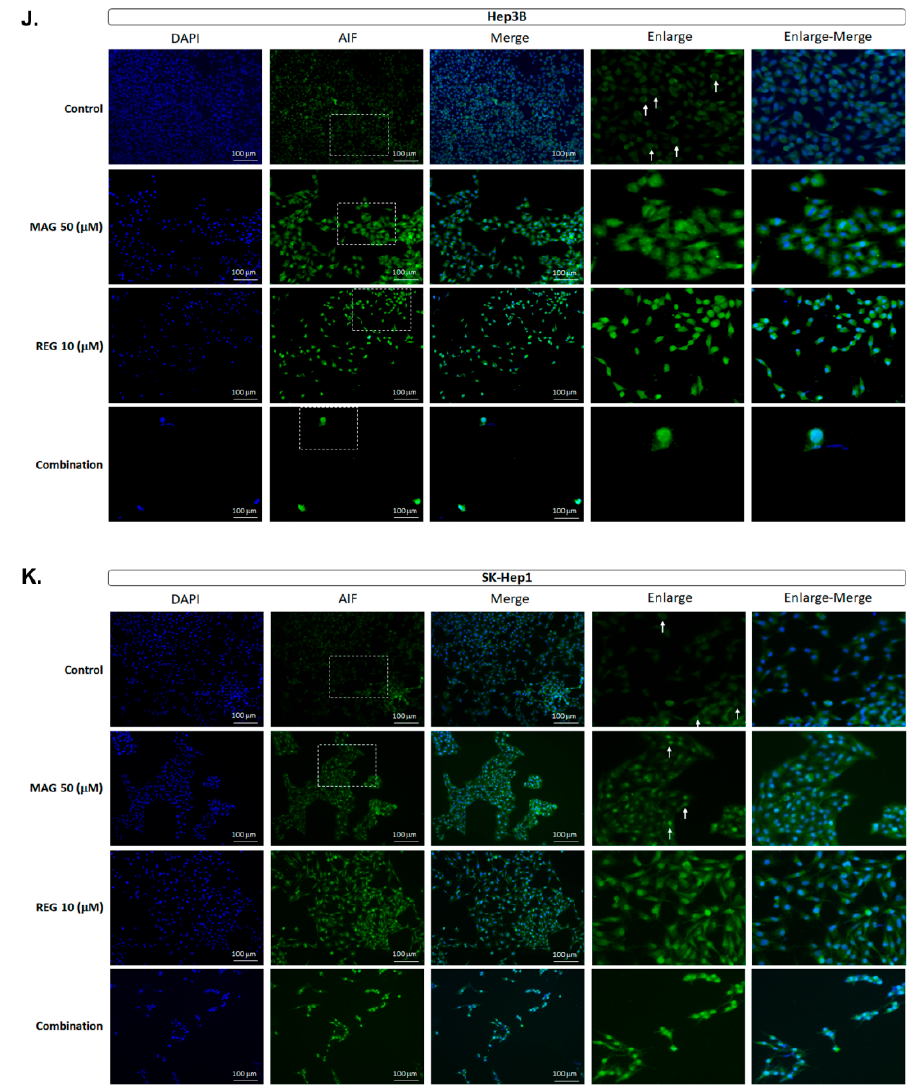
Figure 5. The caspase-dependent and -independent apoptotic effects of regorafenib were enhanced by magnolol. Hep3B and SK-Hep1 cells were treated with 10 µ M regorafenib, 50 µ M magnolol, and a combination for 48 h and assayed by flow cytometry using ( A ) FAS staining, ( B ). FAS-L staining, ( C ) cleaved caspase-8 staining, ( D ) DCFH-DA staining for ROS, ( E ) DIOC 6 staining for △ ψ m, ( F ) Fluo-3/AM for Ca 2+ , and ( G ) cleaved caspase-9. The Western blotting of BAX, BAK, FAS, FAS-L, cleaved caspase-3 (cleaved C3), -8 (cleaved C8), -9 (cleaved C9), and cleaved PARP-1 in ( H ) the Hep3B and ( I ) SK-Hep1 cells. The IF staining of AIF in ( J ) Hep3B and ( K ) SK-Hep1 cells. (a 2 p < 0.01 vs. CTRL; b 2 p < 0.01 vs. 10 μ M REG or 50 μ M MAG; scale bar = 100 μ m).